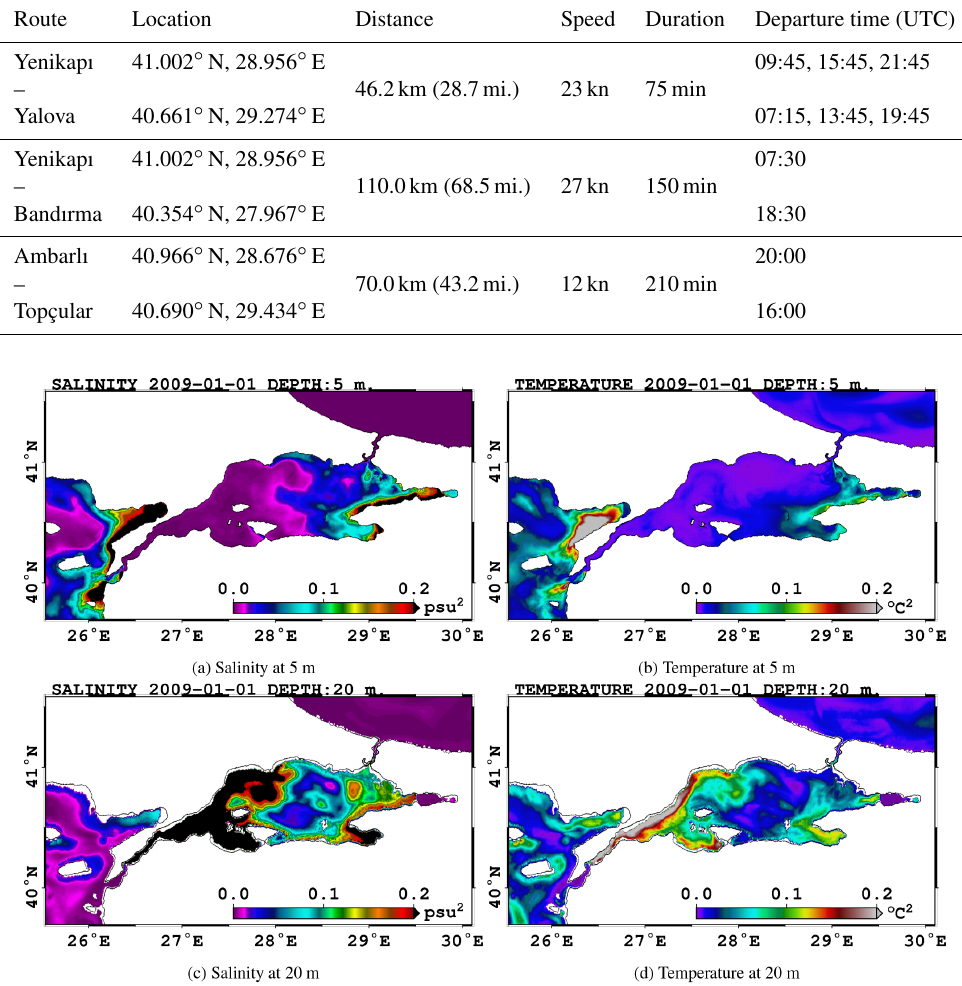
Table 1. The unidirectional ferry tracks used in this study. The locations, distance between the ports, speed of the ferries, duration of the cruise and time of departure from each port are listed.